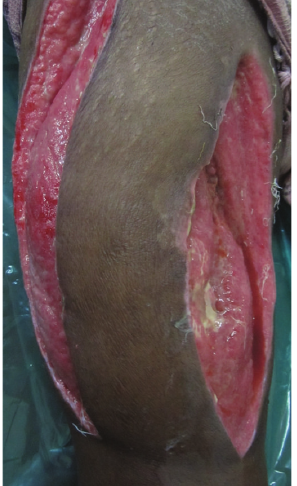
Figure 5: Wound after debridement—granulating wound on right thigh (lateral